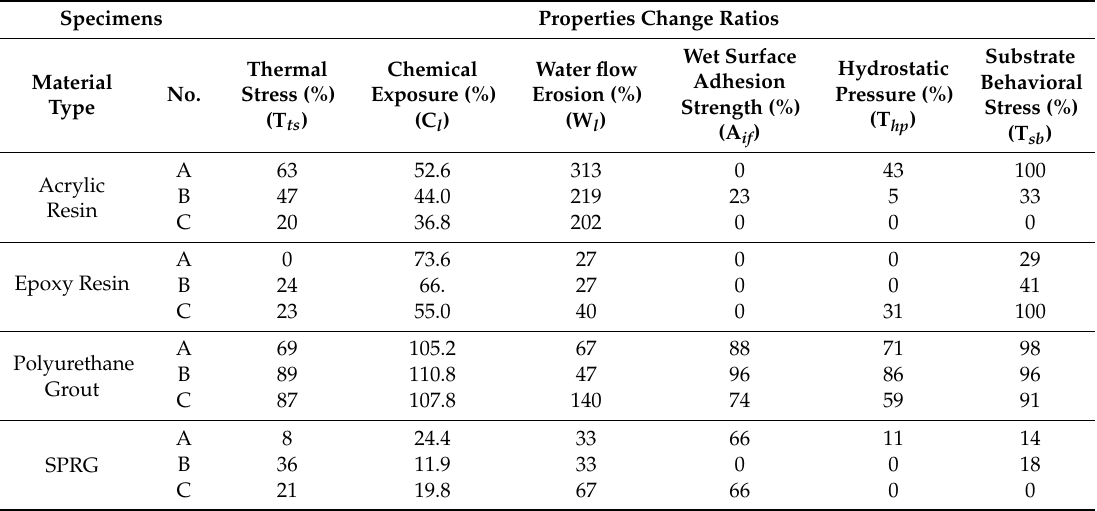
Table 10. The physical properties change measurement comparison results of grout-injection materials. Specimens